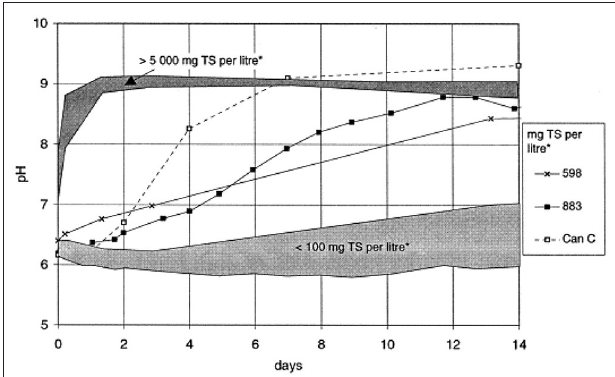
FIGURE 5 | Variations of pH during storage of urine with different concentrations of feces. Reprinted with permission from Hellström et al. (1999). Copyright © 1999 Elsevier Science B.V. All rights